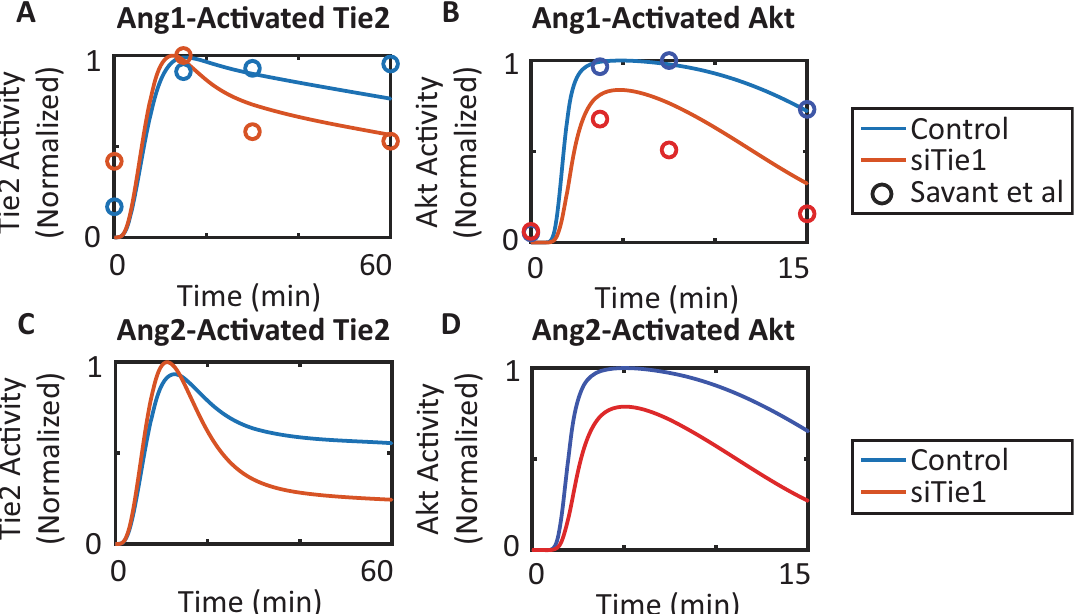
Fig. 4 Tie1 sustains the activation of Tie2 and its downstream signaling and is essential for Ang2 ’ s agonistic activity. Tie1 silencing acutely enhances but chronically suppresses Tie2 activation by ( A ) Ang1 and ( C ) Ang2. Tie1 silencing suppresses Akt activation by ( B ) Ang1 and ( D ) Ang2. Tie2. Tie1 silencing converts low concentration Ang2 into an antagonist of Ang1-activated Tie2 (Supplementary Fig. 1). The results indicate that Tie1 ’ s ability to sustain activated Tie2 at the endothelial junctions is essential for Ang2 ’ s agonistic activity and are consistent with the observation that loss of Tie1 potentiates Ang2 ’ s antagonistic effect.